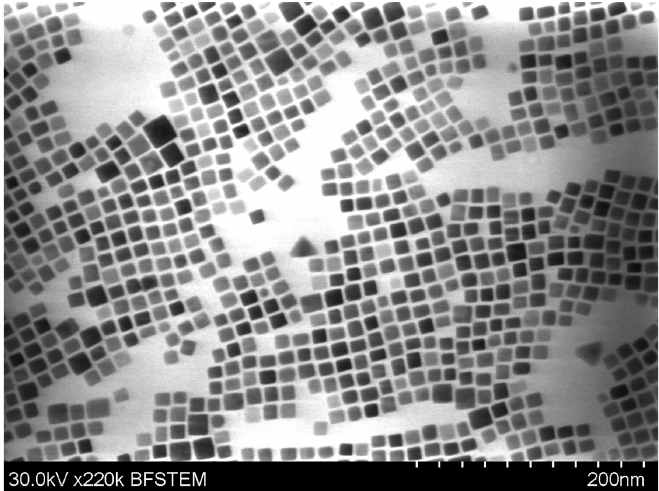
Figure 5. Representative TEM image of the core–shell iron oxide hydrophobic magnetic nanoparticles with the cubic structure of edge length of 15 ± 2 nm. TEM image of the cubic shape MNPs. The nanocubes have a very regular cubic shape without any edge truncations.